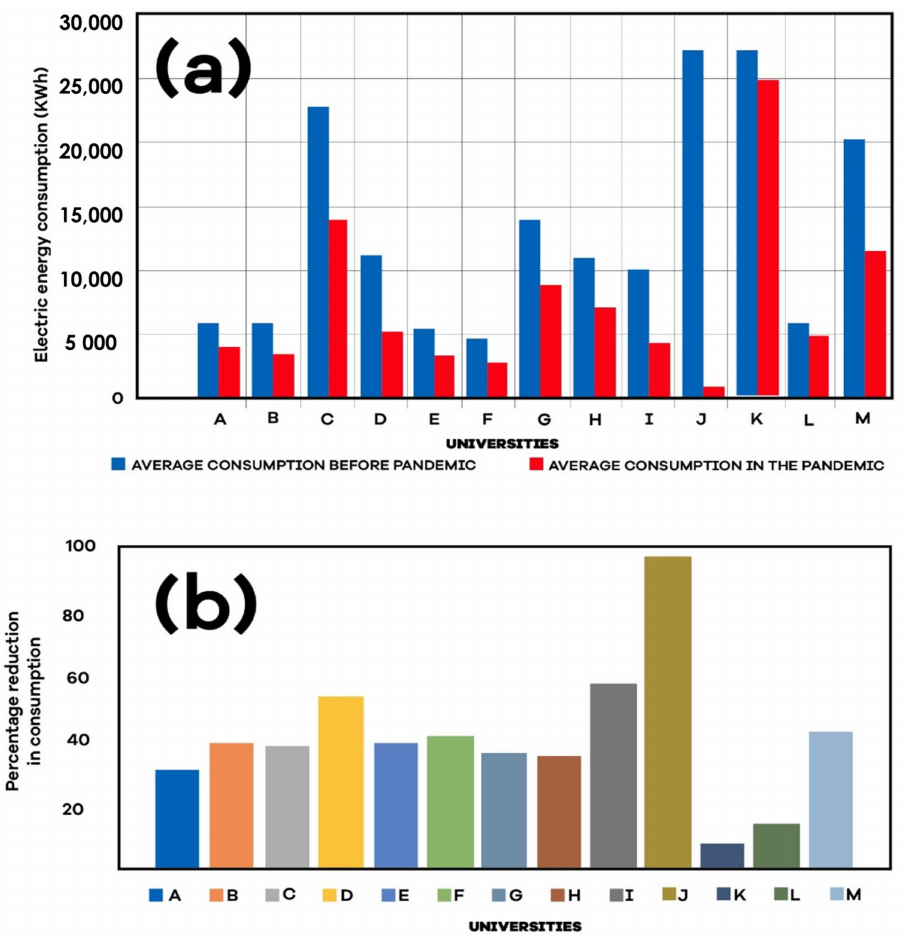
Figure 2. ( a ) Comparative analysis in the average monthly consumption of electrical